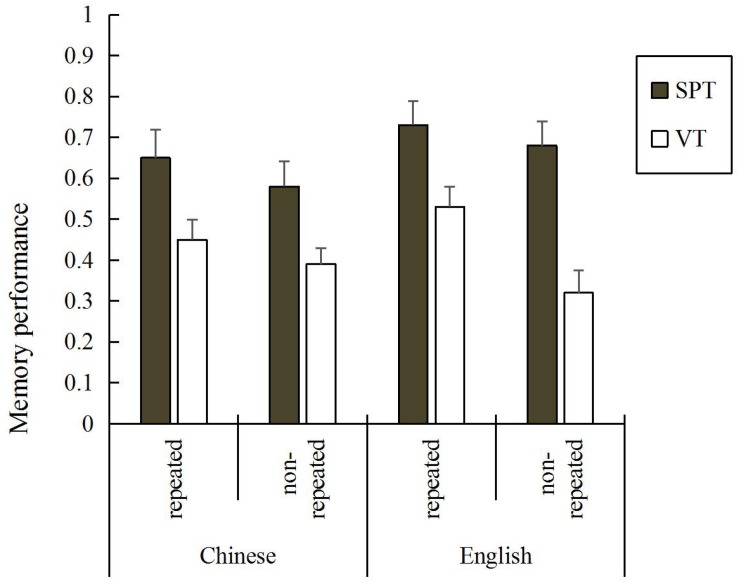
Mean memory performance per encoding condition, language, and semantic repetition condition. Bars represent standard errors.